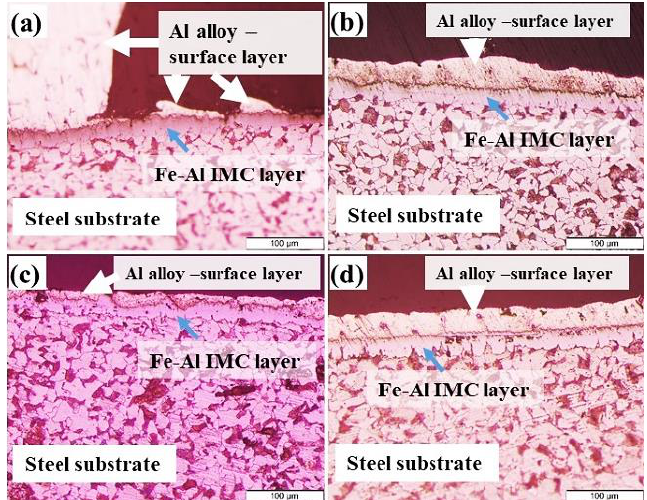
Figure 2. Cross-section microstructures of steel with Al alloy coating; ( a ) steel with flux pre-treatment surface and dipping time for 30 s; ( b ) steel with Sn pre-treatment surface and dipping time for 30 s, ( c ) steel with flux pre-treatment surface and dipping time for 150 s; ( d ) steel with Sn pre-treatment surface and dipping time for 150 s.